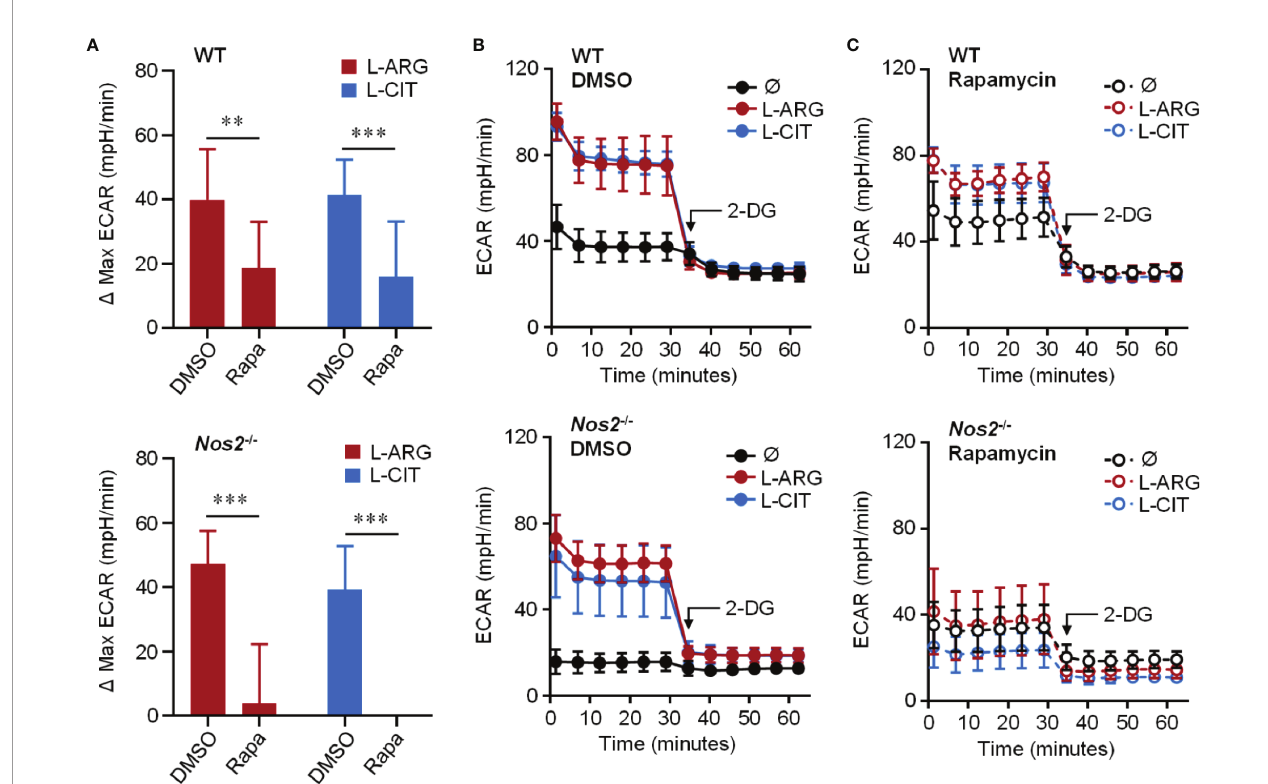
FIGURE 5 | Requirement of mTORC1 for L-arginine/L-citrulline-enhanced glycolysis. PM F s from C57Bl/6 (WT) or Nos2 -/- mice were stimulated with Pam3Cys plus IFN- g in R-free C-DMEM containing 400 m M L-arginine, L-citrulline, or neither amino acid with rapamycin or vehicle control (DMSO) for 24 hours. Following stimulation, cells were incubated in R-free Seahorse media containing 400 m M L-arginine (red), L-citrulline (blue), or neither amino acid (black) for 1 hour followed by ECAR analysis as in Figure 4 . Data are shown as (A) the differences in maximum ECAR between DMSO and rapamycin groups or (B, C) the raw ECAR values (N = 10, WT, two experiments combined; N = 5, Nos2 -/- , one experiment). **p < 0.01, ***p < 0.001, by 2-way ANOVA with Sidak ’ s post hoc test. Error bars,